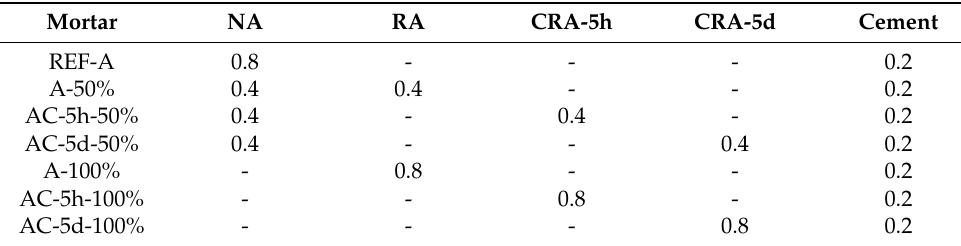
Table 1. Mortars’ composition (in volume, for 1 dm 3 ).